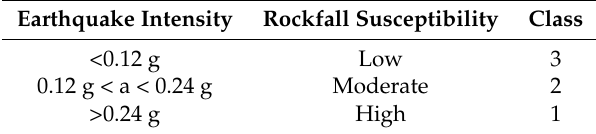
Table 5. Rating of earthquake